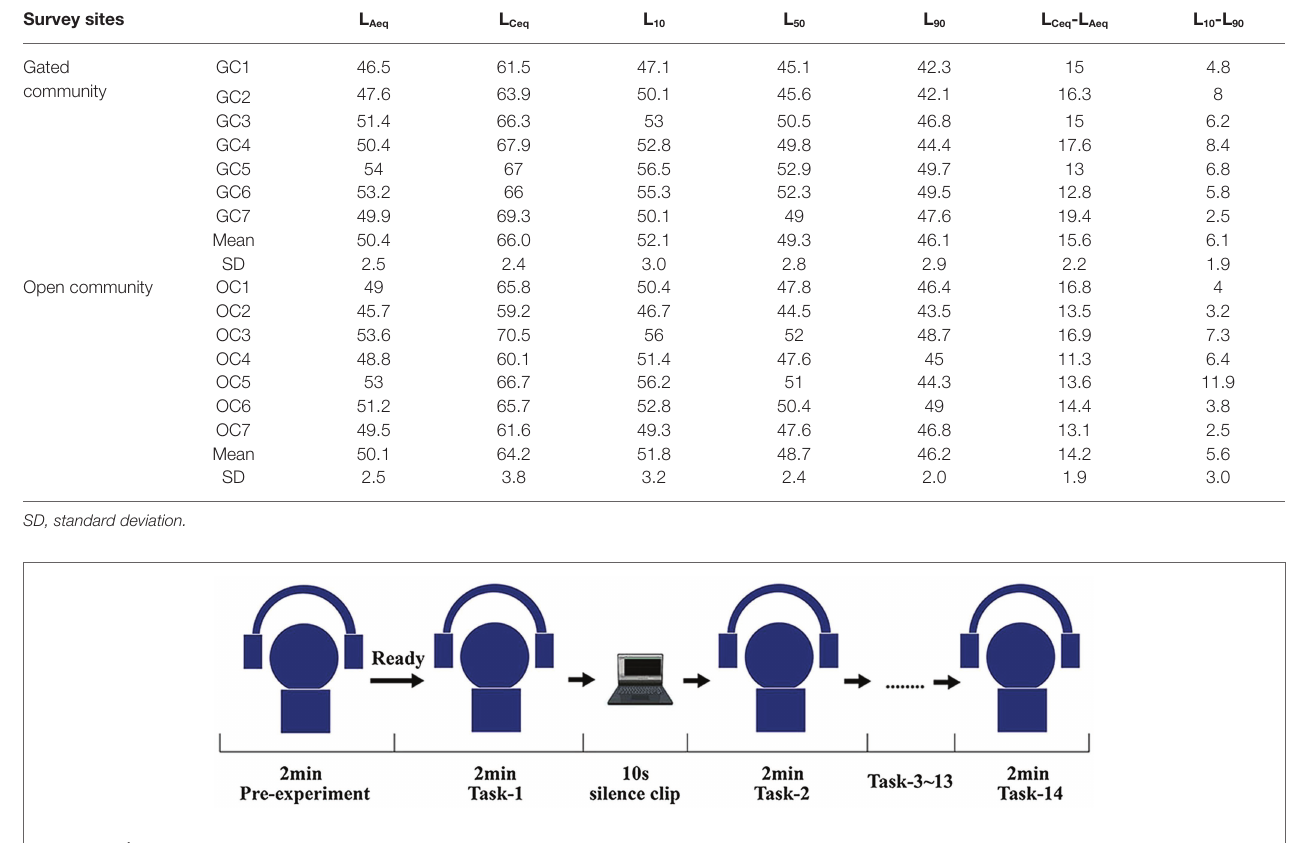
FIGURE 4 | The experimental